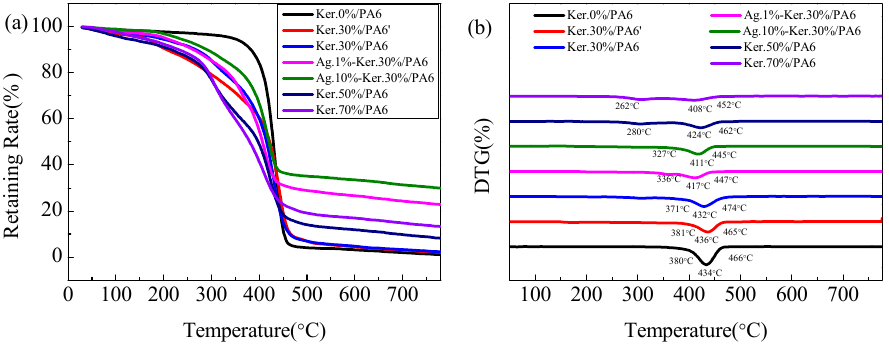
Figure 4. Thermogravimetric Analysis (TGA) ( a ) and Derivative Thermogravimetry (DTG) ( b ) of as-prepared nanofiber films.